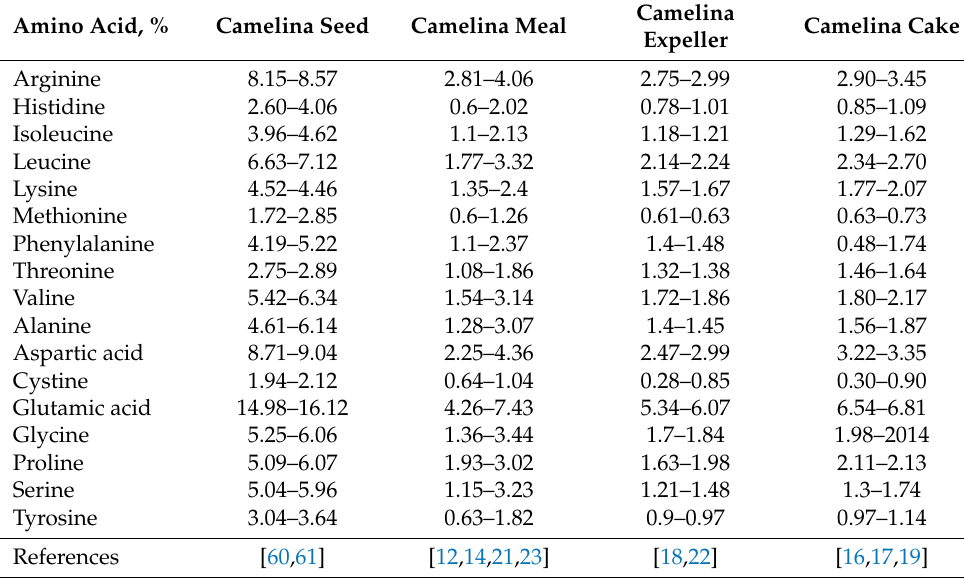
Table 4. Amino acid profile of Camelina sativa seed, meal, expeller, and cake (% total amino